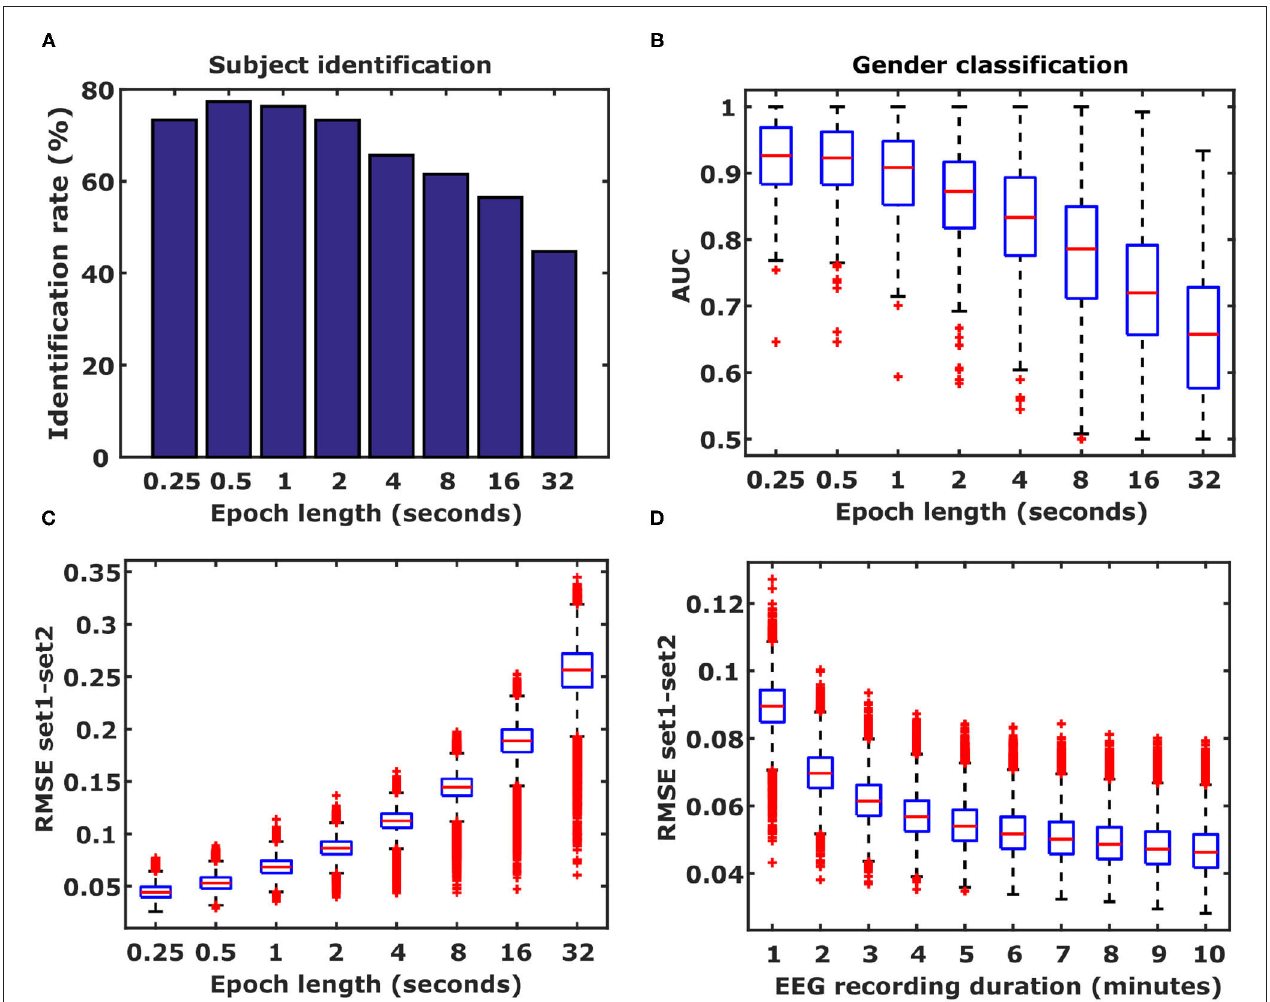
FIGURE 5 | Influence of epoch length and frequency band. (A) Identification rates based on different epoch lengths. Epoch lengths ranged from 250 ms to 32 s. (B) Shorter epochs improve gender classification performance. Results from 500 Monte Carlo cross-validation repetitions are shown. Boxplots represent median (stripe), 25 th and 75th percentiles (box), 1.5 times the interquartile range (whiskers), and outliers (crosses). (C) Epoch length is inversely related to DFC coefficient estimation accuracy. (D) EEG duration is also inversely related to the duration of the EEG. Boxplots represent the distributions of differences in DFC coefficients between Rest1 and Rest2, averaged over 105 subjects for the α 1 frequency band (26565 DFC